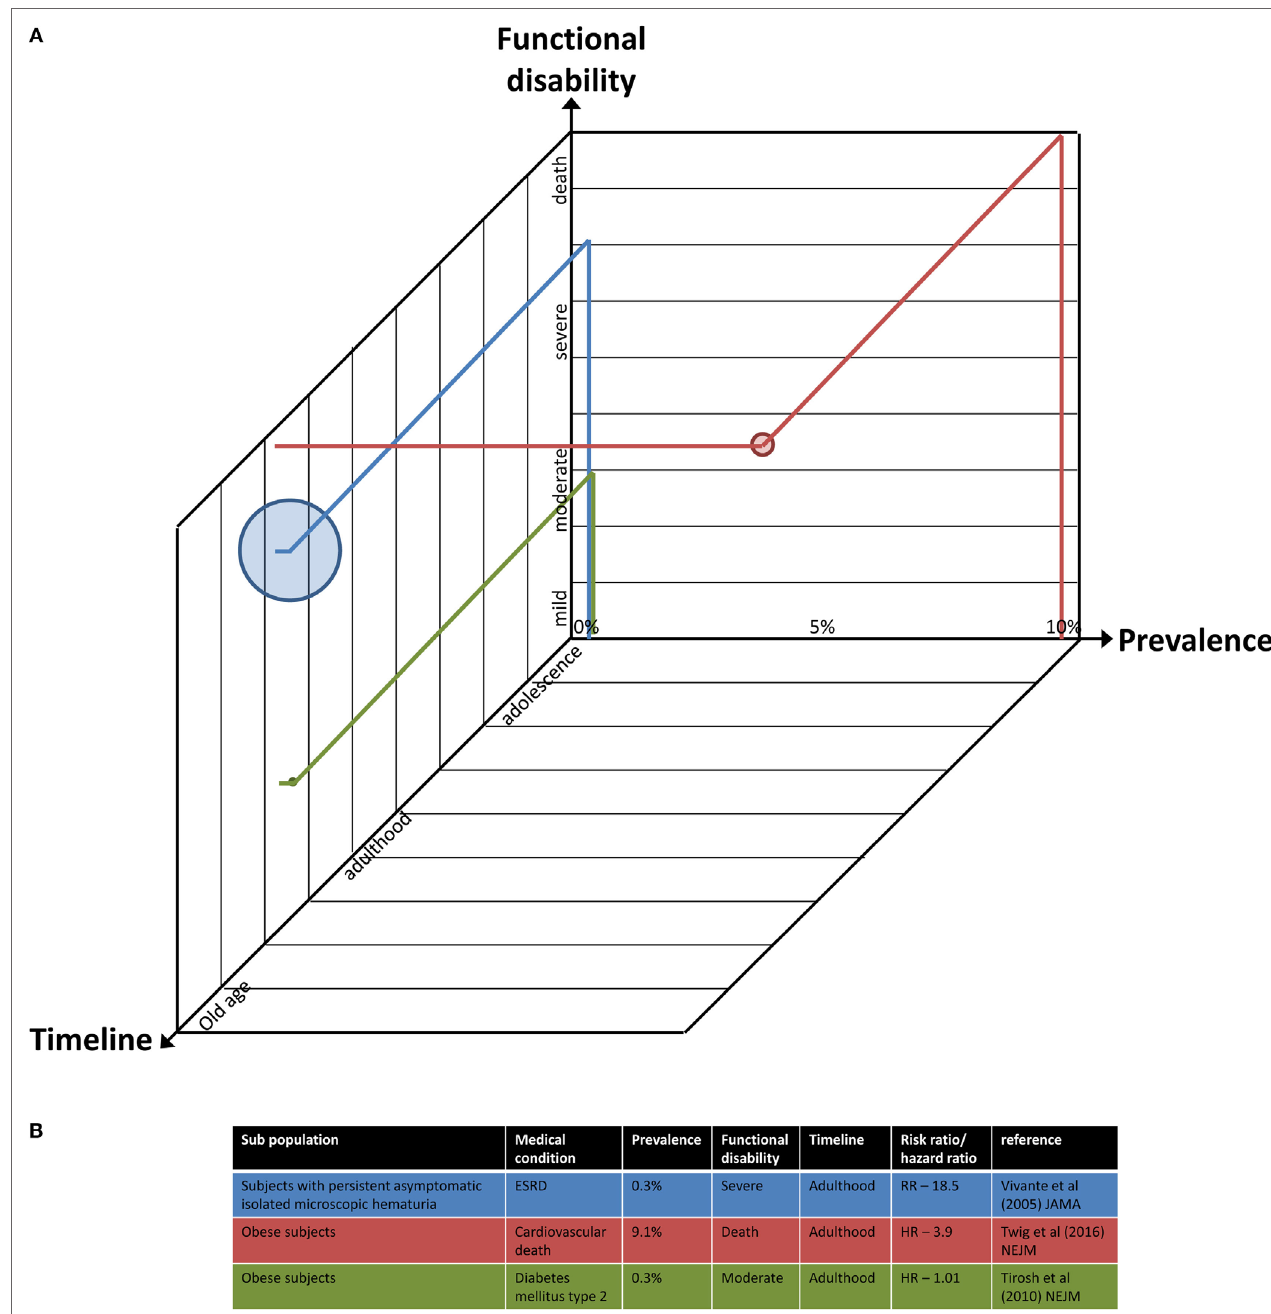
FigUre 2 | A multidimensional illustration of the parameters to estimate the risk for future morbidity. (a) The axes represent current/future prevalence of a medical condition among the population (percentage), time frame of its occurrence (adolescence to old age scale), and the estimated functional disability imposed by the grade of its severity (mild to severe and even death). The size of each point is proportional to the odds/risk/hazard ratio for morbidity or mortality. Projection of data of three exemplary studies into the illustration is provided. (B) Details of the data and studies used in panel (a)